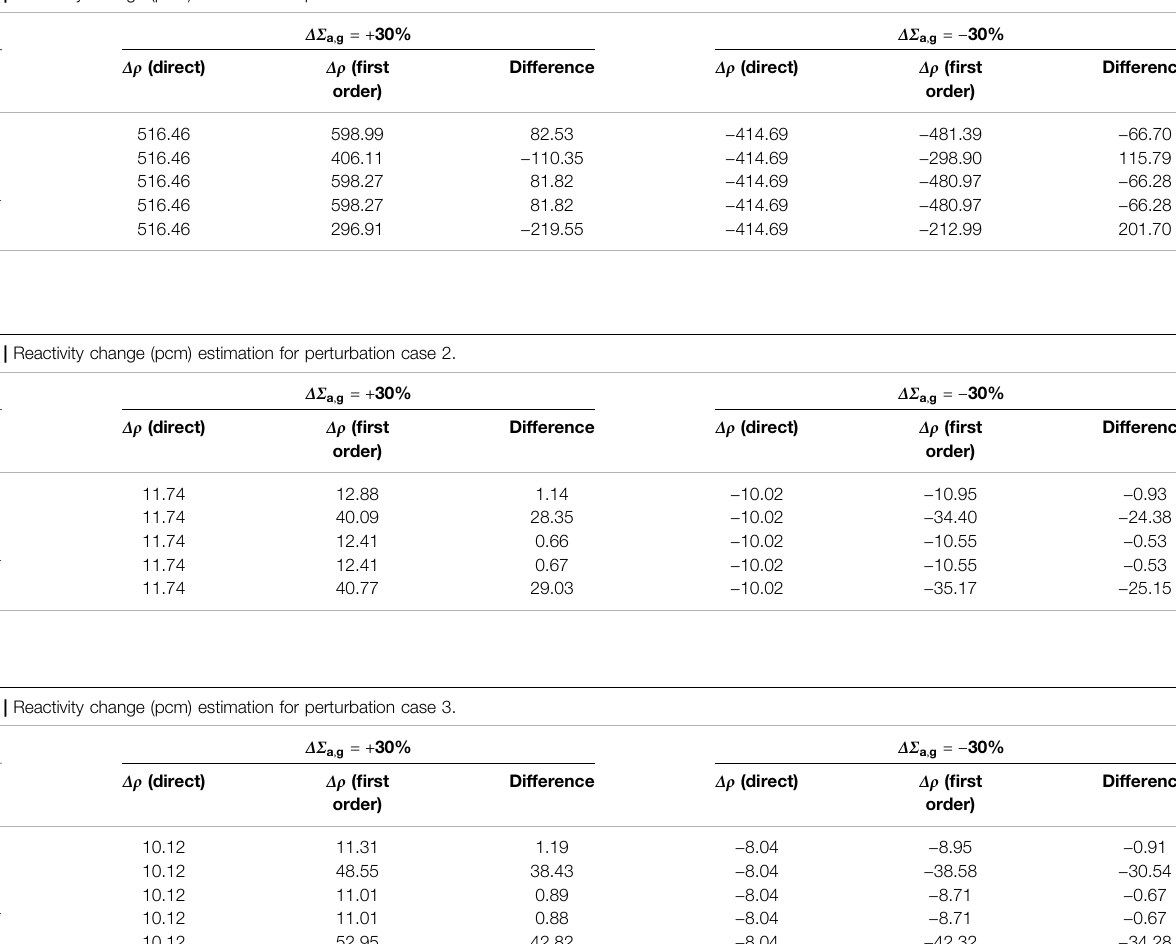
TABLE 5 | Reactivity change (pcm) estimation for perturbation case 1.